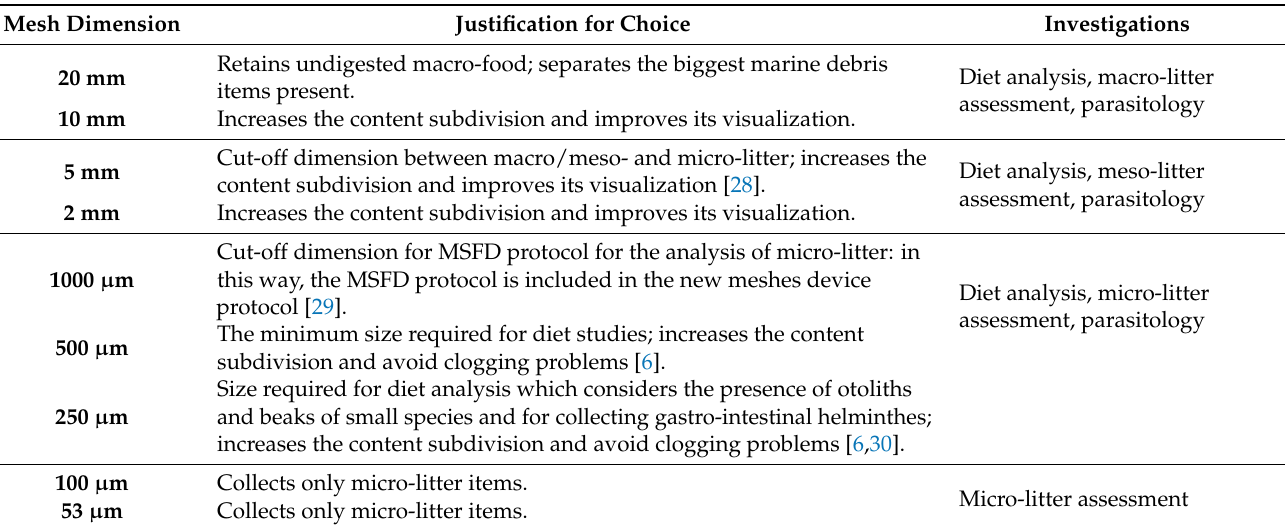
Table 2. Mesh dimensions selection and justification for the choice they were selected. 20 mm, 10 mm, 5 mm and 2 mm sieves are composed of square meshes created ad hoc, 1000 µ m, 500 µ m, 250 µ m and 100 µ m sieves are round laboratory sieves. In the third column are reported the investigations which that can be performed on the content collected by each sieve. Mesh Dimension